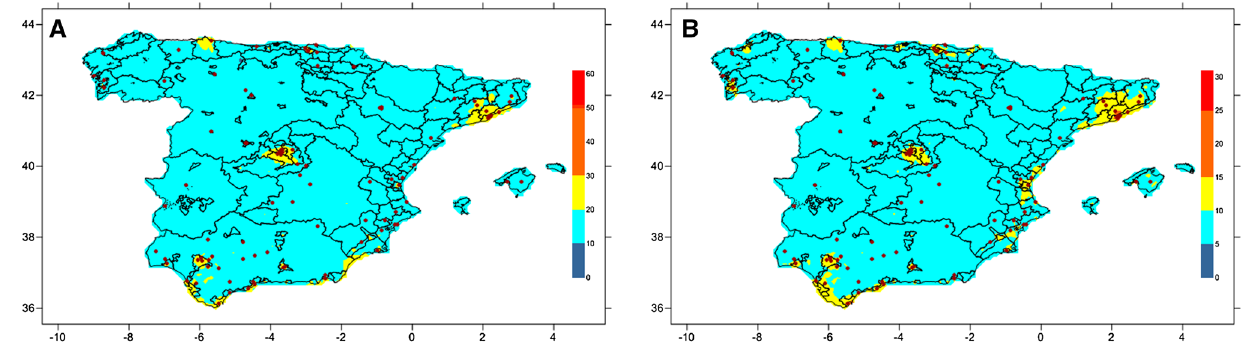
Figure 3. Modeled mean PM 10 (3 A ) and PM 2.5 (3 B ) concentrations in μg/m 3 from 2008 to 2016 in Spain. Concentration values were calculated by applying the CHIMERE model (chim2013, https:// www. lmd. polyt echni que. fr/ chime re/). The graphic was created with surfer (surfer 17) https:// www. golde nsoft ware. com/ produ cts/ surfer. Red dots indicate the location of clusters included in the di@bet.es study. Colour ranges are based on WHO air quality guidelines and interim targets for particulate matter 20